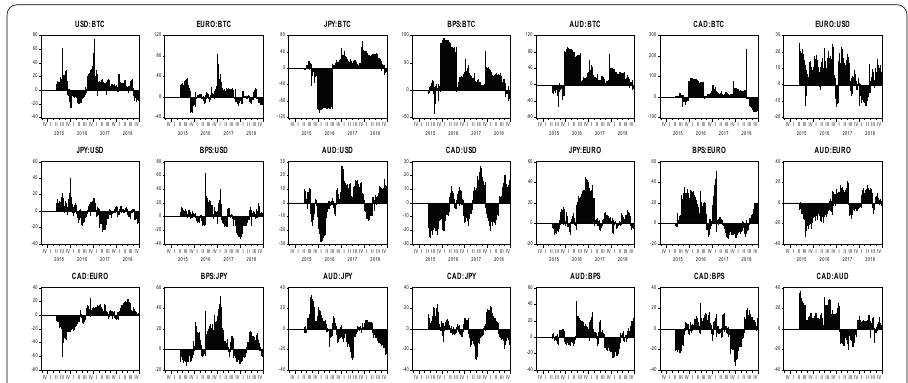
Fig. 9 Directional TO SAM (250 days rolling window)—Bitcoin market and foreign exchange pairs of major trading currencies SAM H 2 N , i →• The Y-axis depicts the volatility spillover values and the X-axis depicts the time period